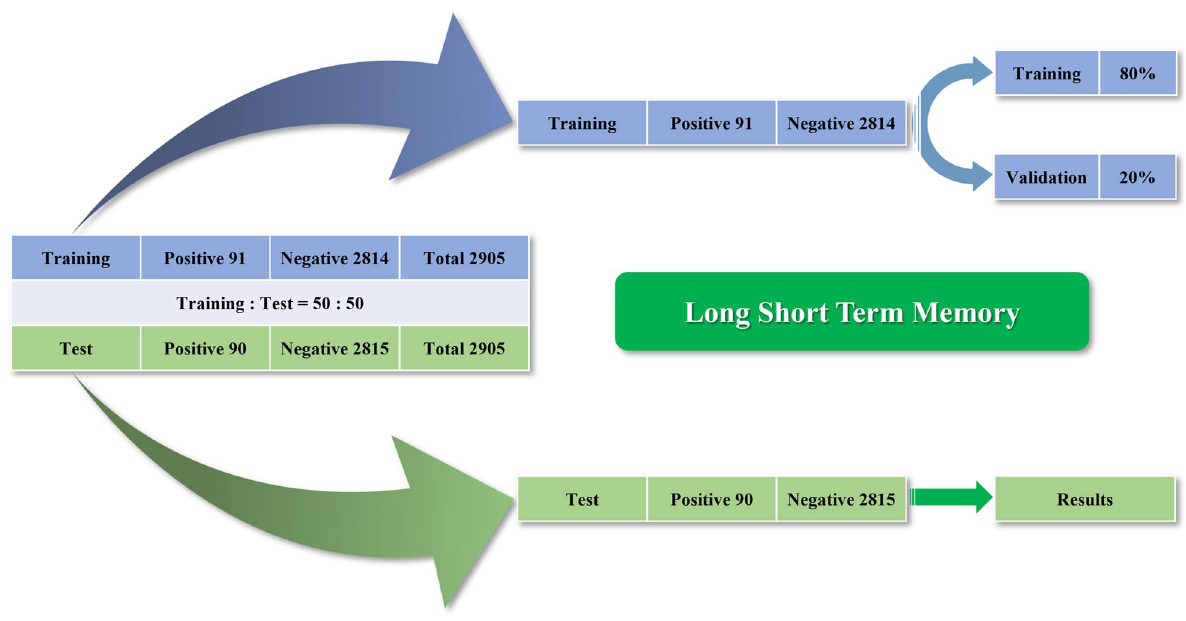
Figure 2. Composition of the training and test